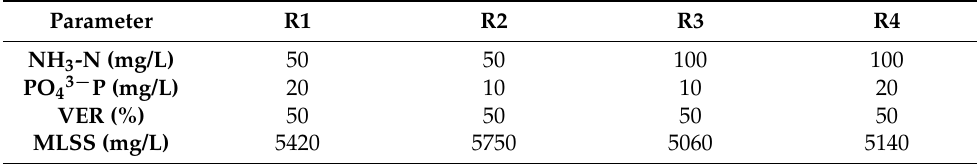
Table 3. Operational parameters in